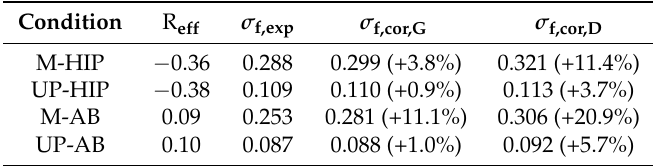
Figure 14. Haigh diagram with residual stresses accounted for according to Dietmann. Table 7. Mean stress corrected fatigue strength values.